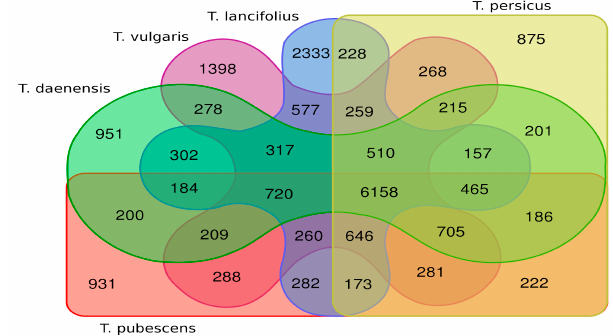
Figure 1. Venn diagram showing the number of overlapping proteins between the five Thymus transcriptome assemblies.